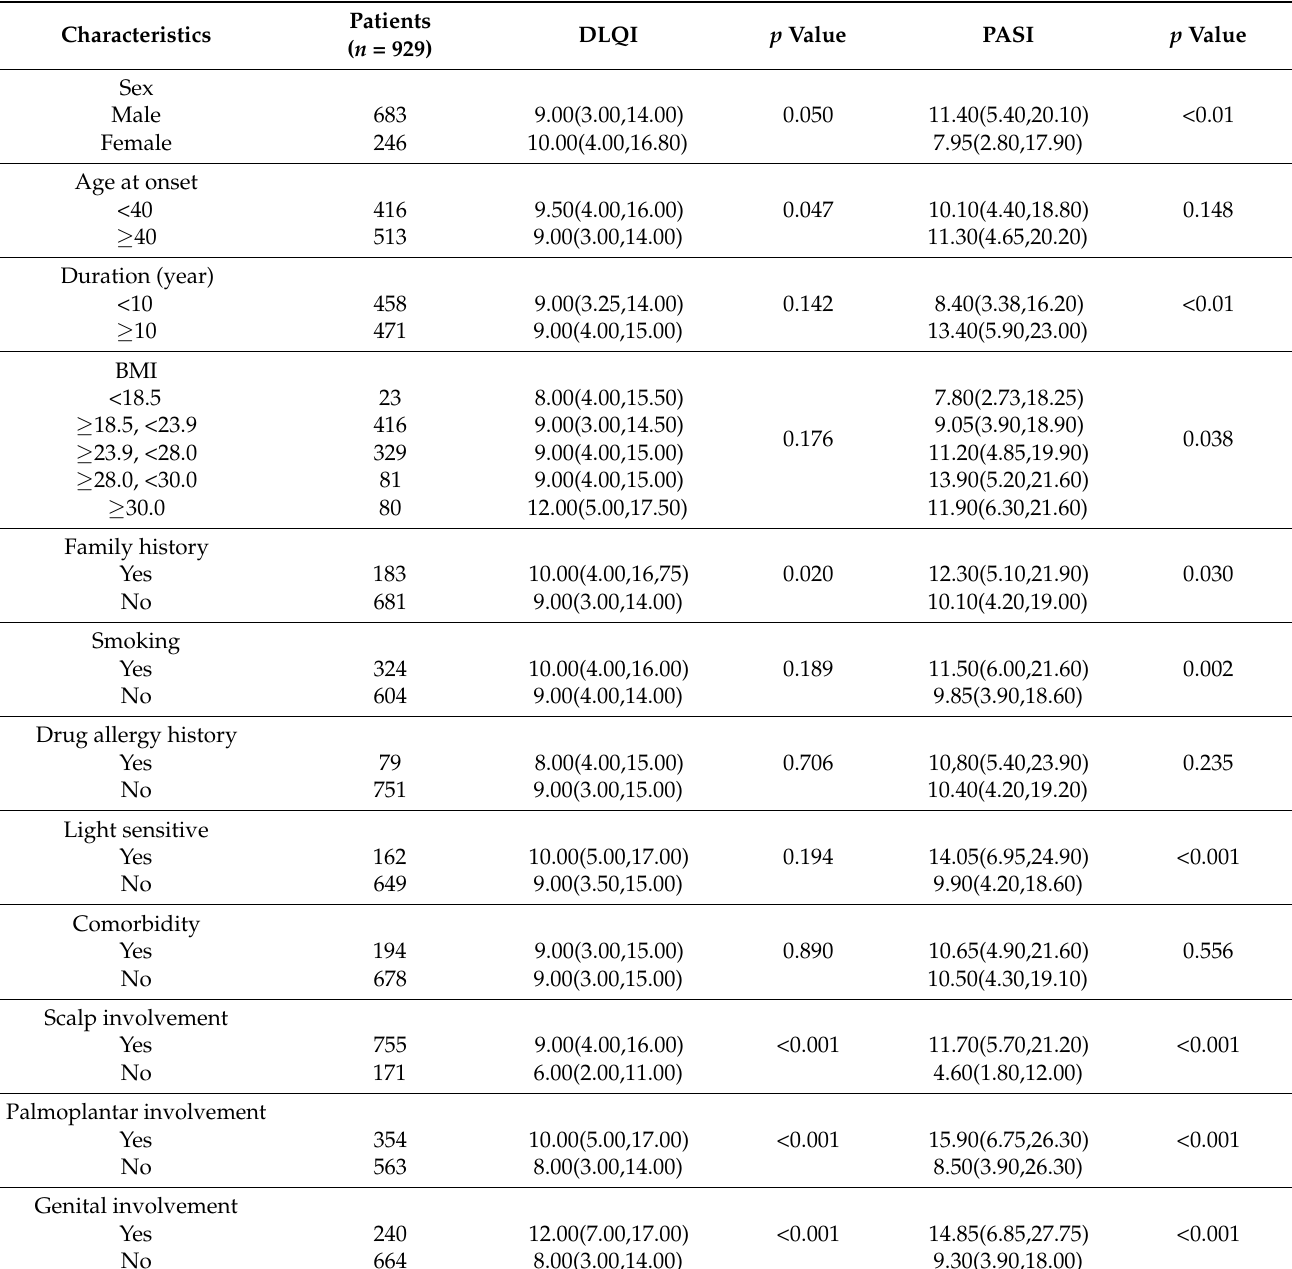
Table 2. Demographic and clinical characteristics with DLQI and PASI score in nail involvement